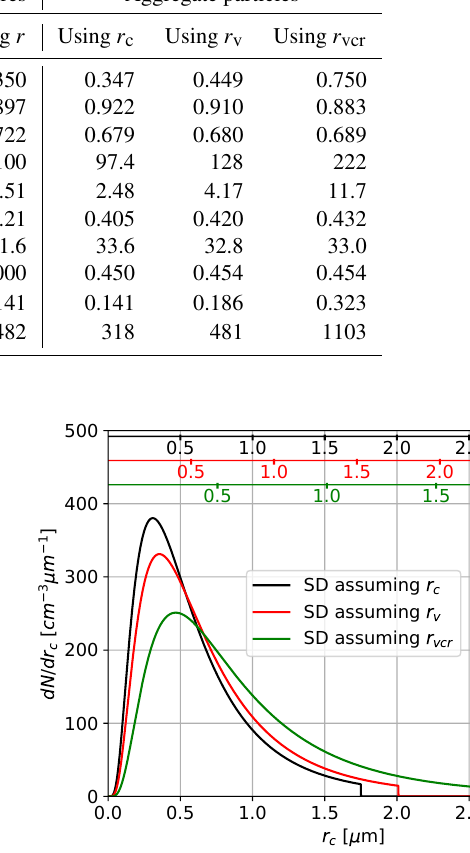
Table 5. Properties of one-modal size distribution at λ = 532nm consisting of spheres or aggregate particles (shape D, ξ vc = 0 . 8708; Fig. 1 of Gasteiger et al., 2011b) assuming different size equivalences. For details, see text. Properties